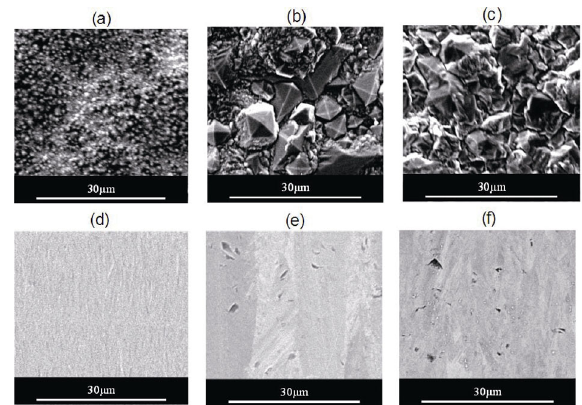
Fig. 1 Surface scanning electron microscopy of silicon carbide coating with different deposition temperatures: (a) lowest, (b) medium, and (c) high; cross-sectional scanning electron microscopy images at different temperatures: (d) lowest, (e) medium, and (f)